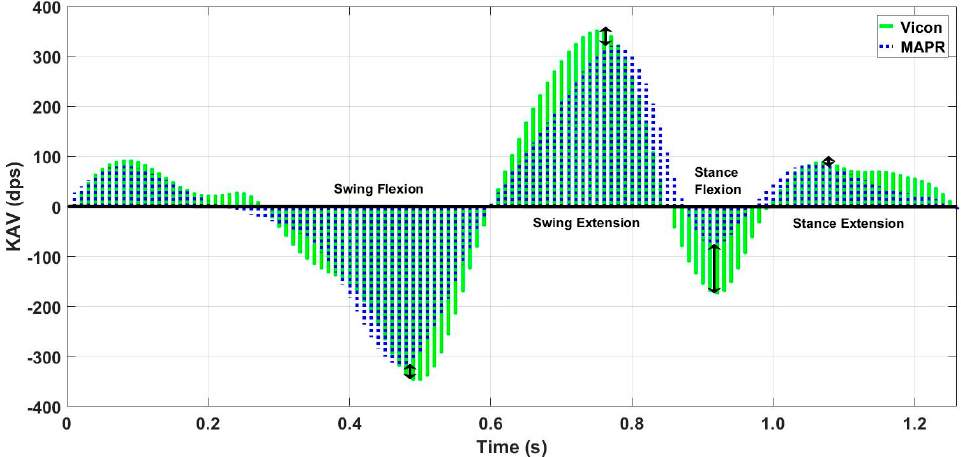
Figure 7. Peak angular velocity comparison of manually aligned Vicon and MAPR KAV Signals. While areas and signal profiles are similar, they differ in location of peaks and depth of peak near HS. Arrows show difference in peak angular velocity for each phase being analyzed using Bland–Altman. Blue, MAPR KAV signal; Green, Vicon KAV signal. Table 2. Bland–Altman Comparing Peak Values of MAPR and OMCS KAV during Flexion and Extension in Stance and Swing.